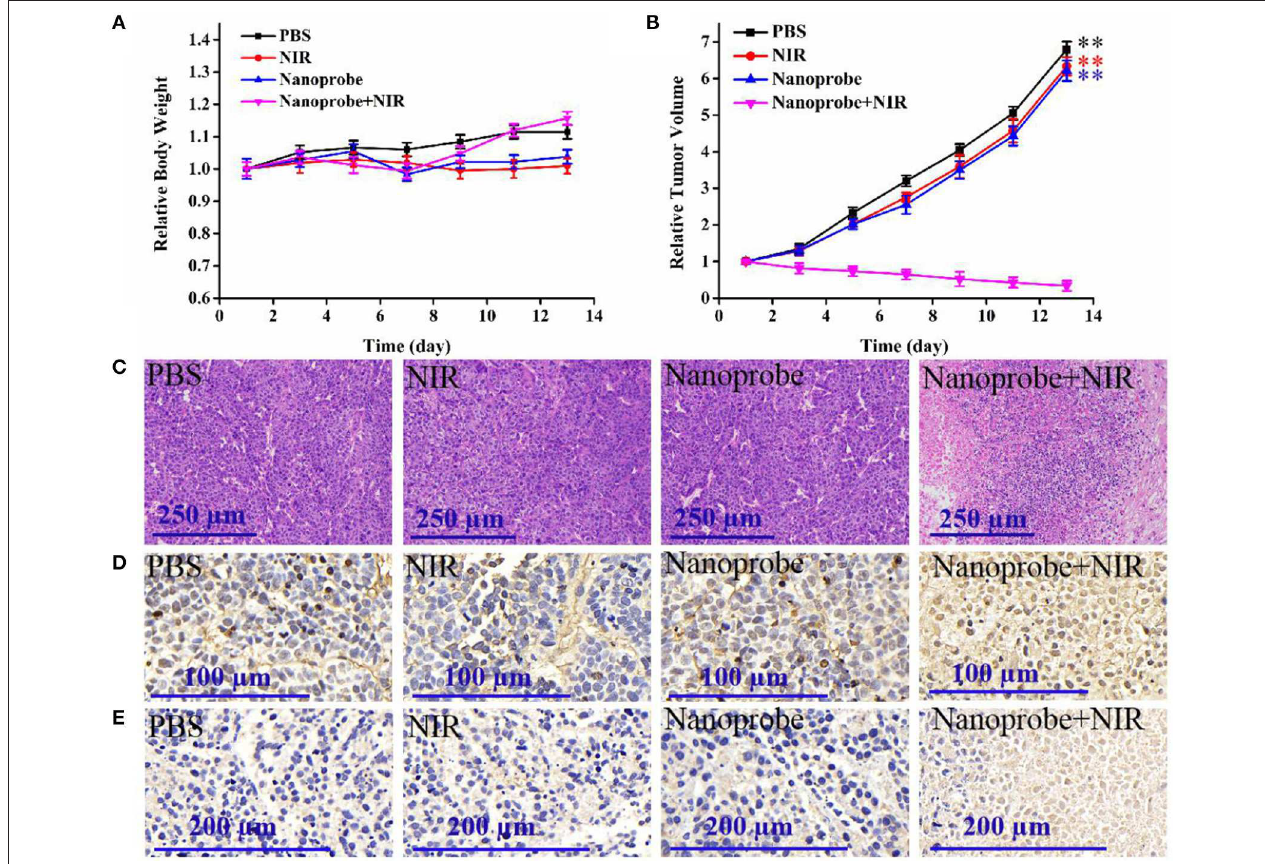
FIGURE 9 | (A) Time-dependent mice body weight curves and (B) tumor growth curves of different groups of mice with various treatments, (C) H&E staining, (D) TUNEL staining, and (E) caspase-3 staining of the dissected tumor section on the thirteenth day with different treatments. Four parallel experiments were operated, and error bars represent standard deviation ( n = 4). The data was analyzed by the T -test. ** p <